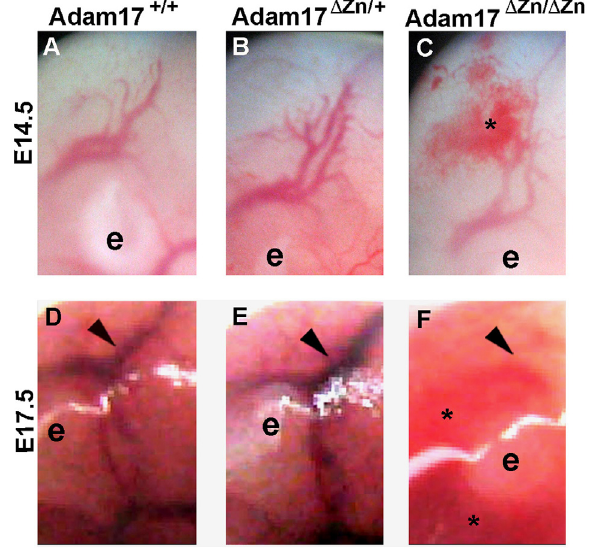
Figure 2. Vascular defects and hemorrhage in Adam17 D Zn/ D Zn embryos. Higher magnifications of the whole unfixed, unstained embryos at E14.5 (A, B, C) and E17.5 (D, E, F) as in Figure 1. Adam17 D Zn/ D Zn embryos (C, F) exhibited blood pooling (star) and loss of visible vascular structures (arrowheads); e =ear.